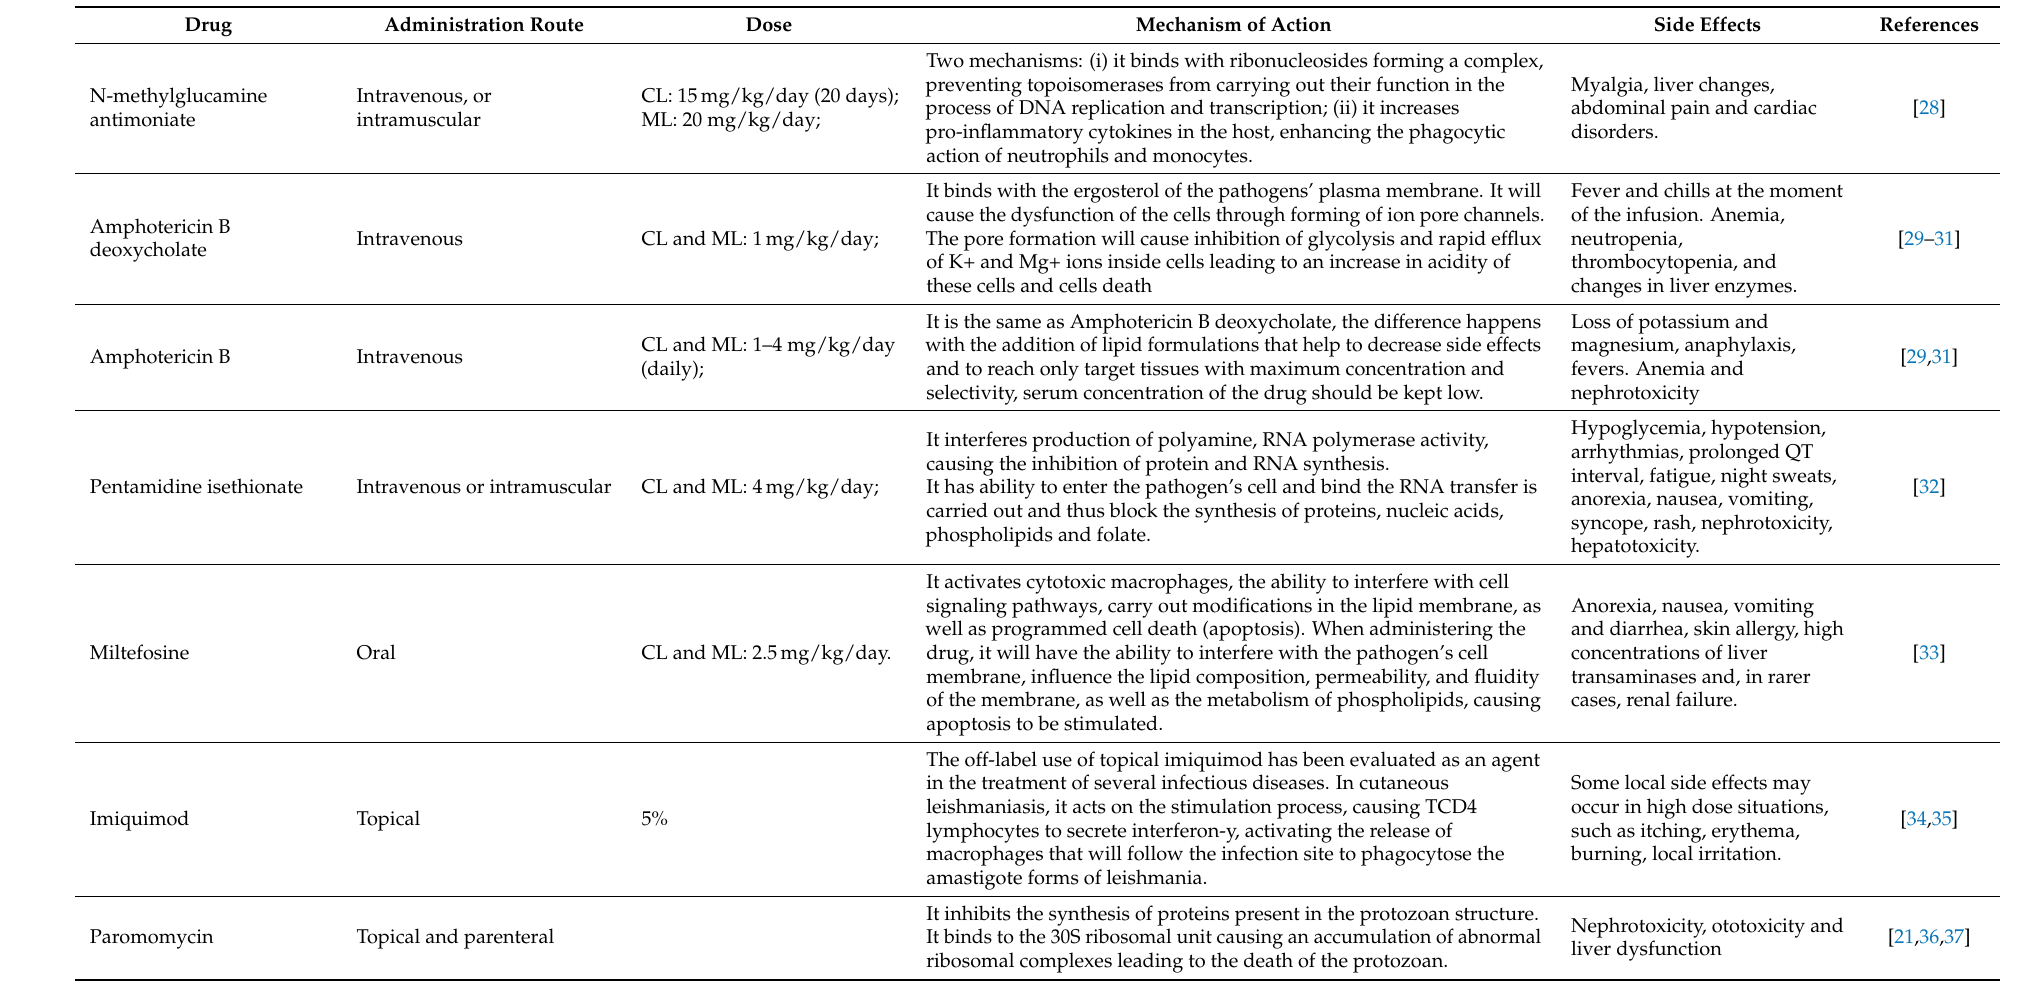
Table 1. Drugs used for the classical treatment of cutaneous (CL) and mucocutaneous leishmaniasis